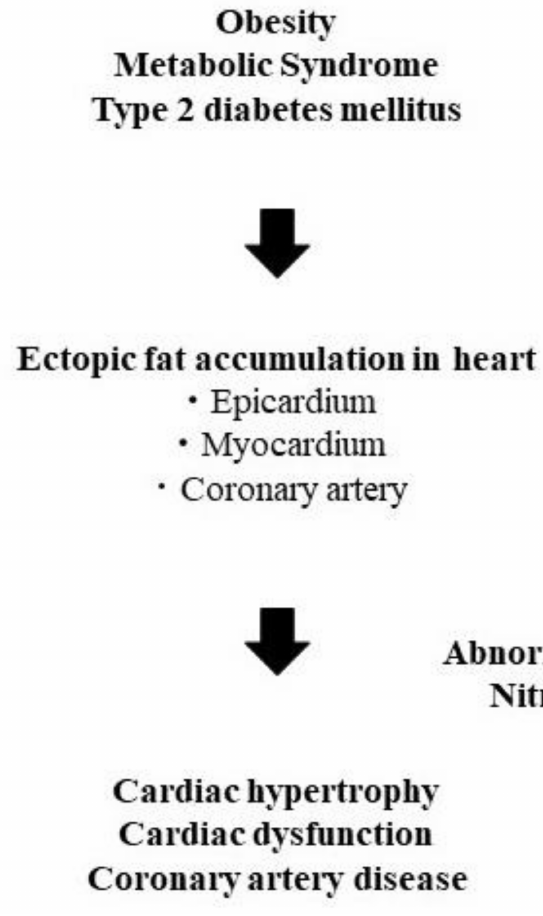
Figure 2. Hypothesis of the pathophysiology of cardiac disease derived from ectopic fat accumulation in